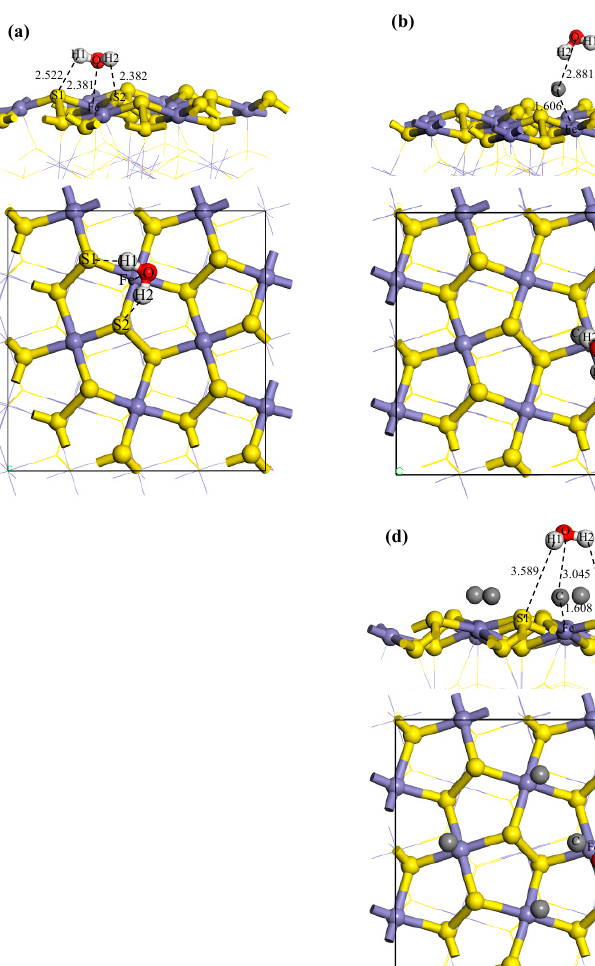
configuration of H 2 O on the ideal pyrite surface; ( b ) H 2 O / AC, the adsorption configuration of H 2 O above